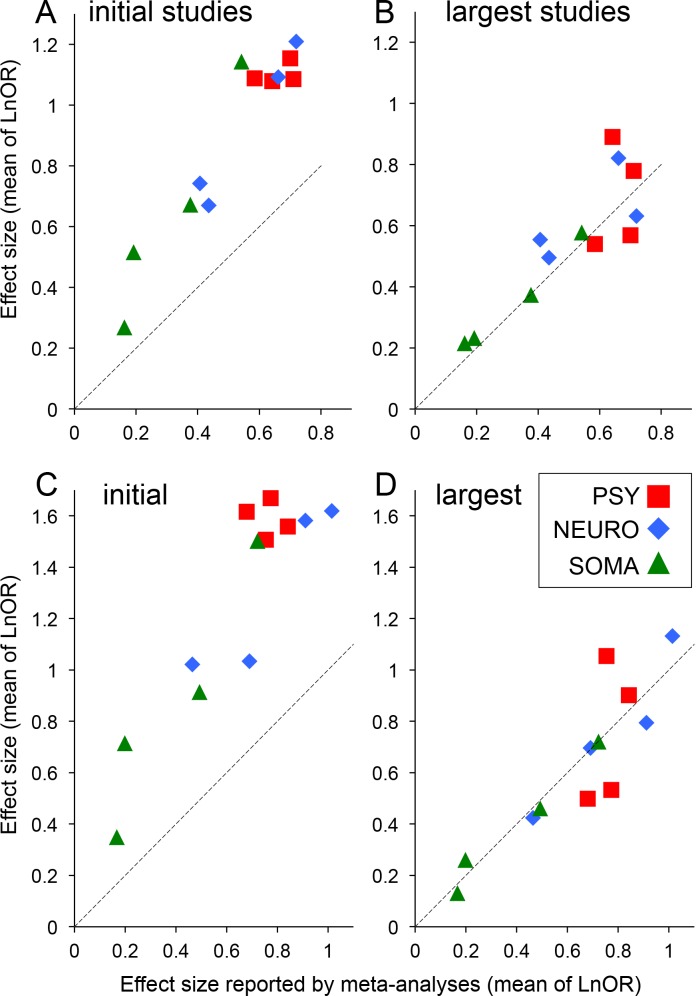
Comparison between effect sizes reported by initial or largest studies and their corresponding meta-analyses.All effect sizes were expressed as LnOR (standardized mean differences were converted to LnOR as described in the Methods). (A) and (C) Mean of the effect sizes reported by initial studies for each pathology. (B) and (D) Mean of the effect sizes reported by largest studies for each pathology. (A) and (B) All 663 trios were considered. (C) and (D) Only the 359 initial studies reporting a significant effect and their corresponding largest studies. The dashed lines correspond to equality between the effect sizes of the initial studies or of the largest studies and the effect sizes reported by the meta-analyses. PSY: psychiatry; NEURO: neurology; SOMA: somatic diseases.